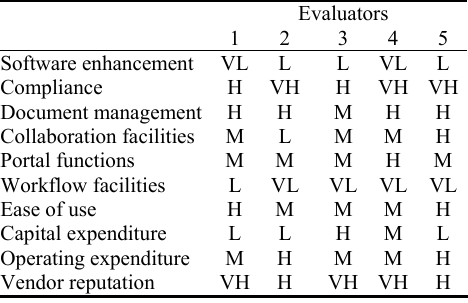
Table 3. The linguistic evaluation of criteria